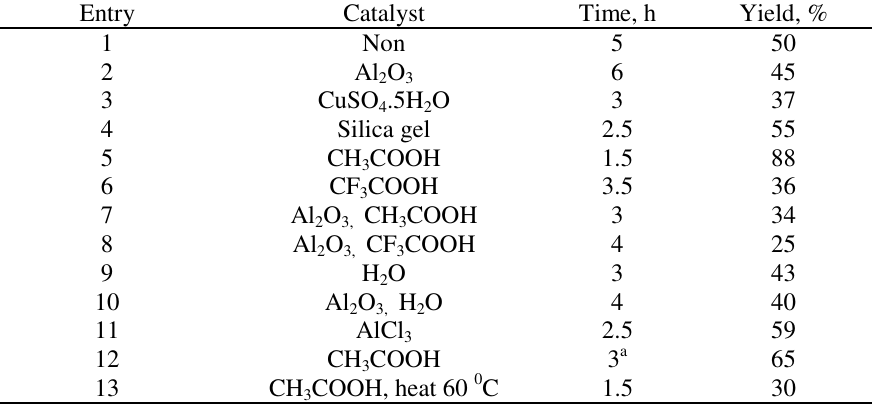
in the presence of different 2